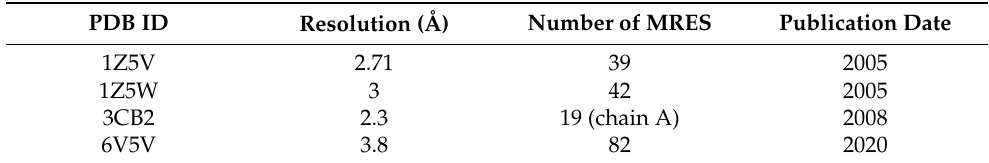
Table 3. Template comparison for γ